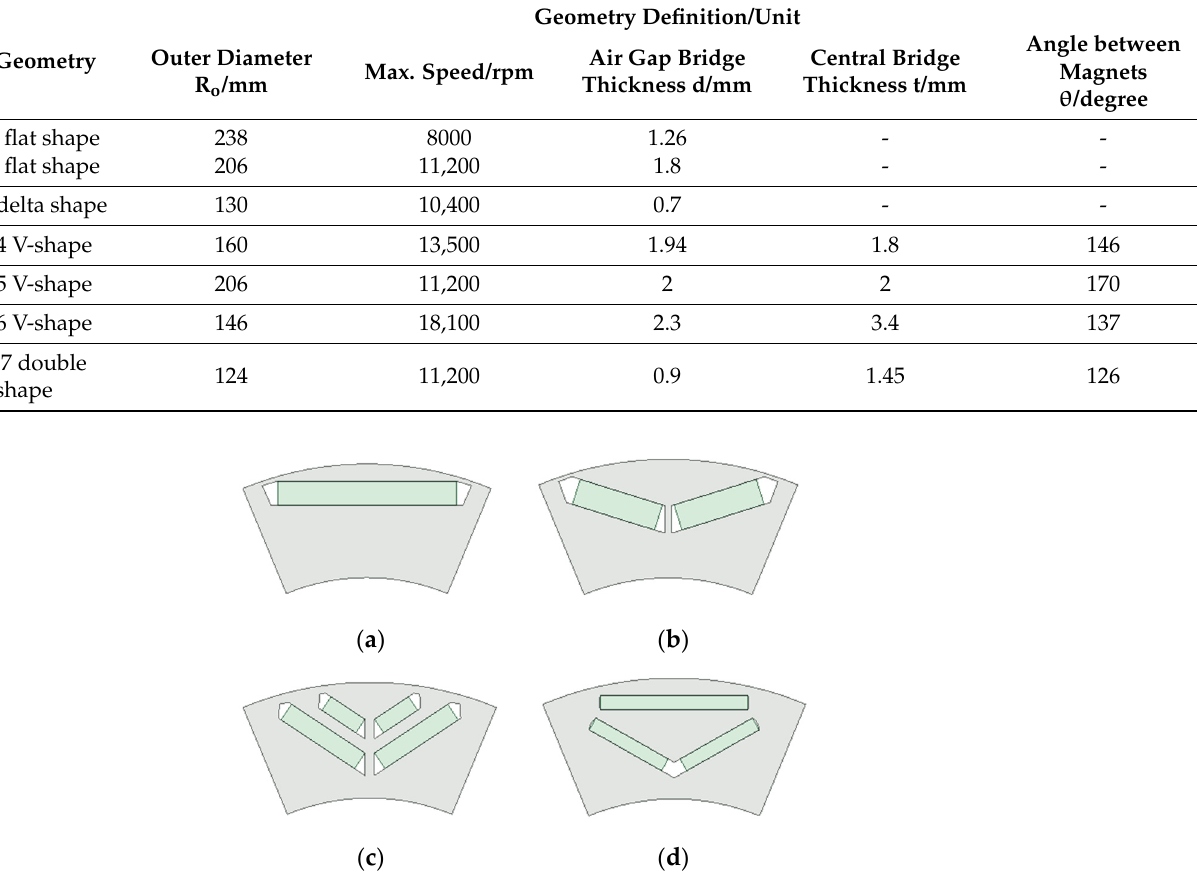
Figure 7. One pole view of the interior permanent magnet rotor geometries ( a ) flat shape, ( b ) V-shape, ( c ) double-V shape, ( d ) delta shape.